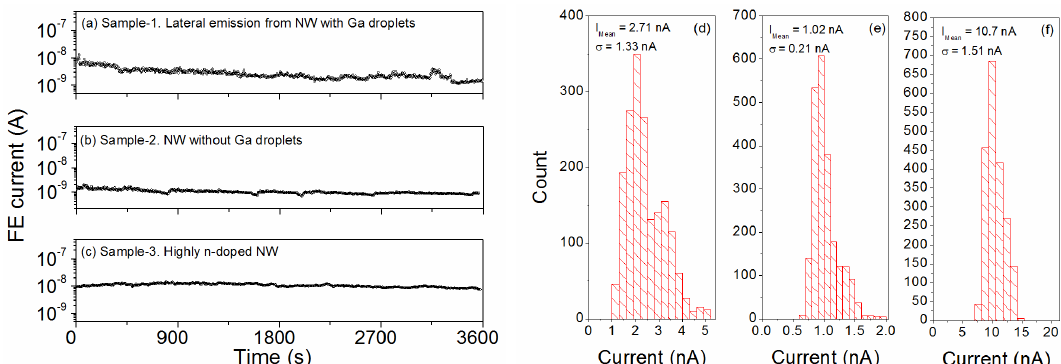
Figure 5. Current stability (FE current vs. time) for Sample ‐ 1 ( a ), measured at a constant bias of 60 V, for Sample ‐ 2 ( b ), measured at a constant bias of 90 V, and for Sample ‐ 3 ( c ), measured at a constant bias of 70 V. Histograms to summarize the statistical analysis on the current values are reported for Sample ‐ 1 ( d ), Sample ‐ 2 ( e ), and Sample ‐ 3 ( f ).